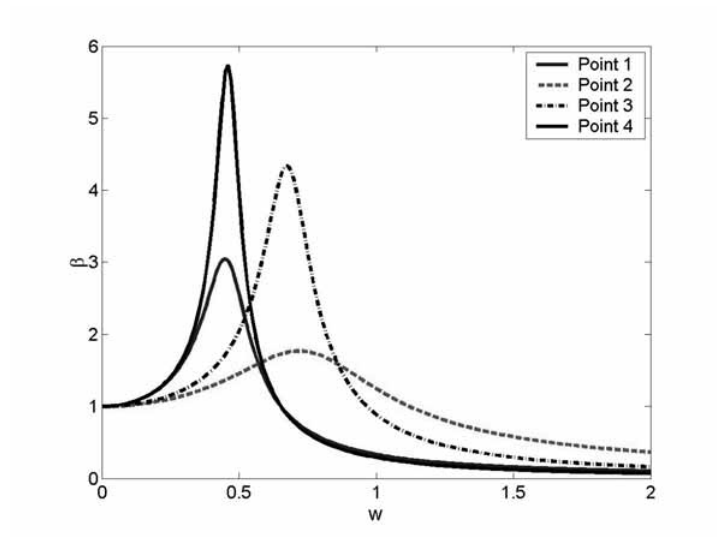
Fig. 26. Optimized absolute displacement frequency